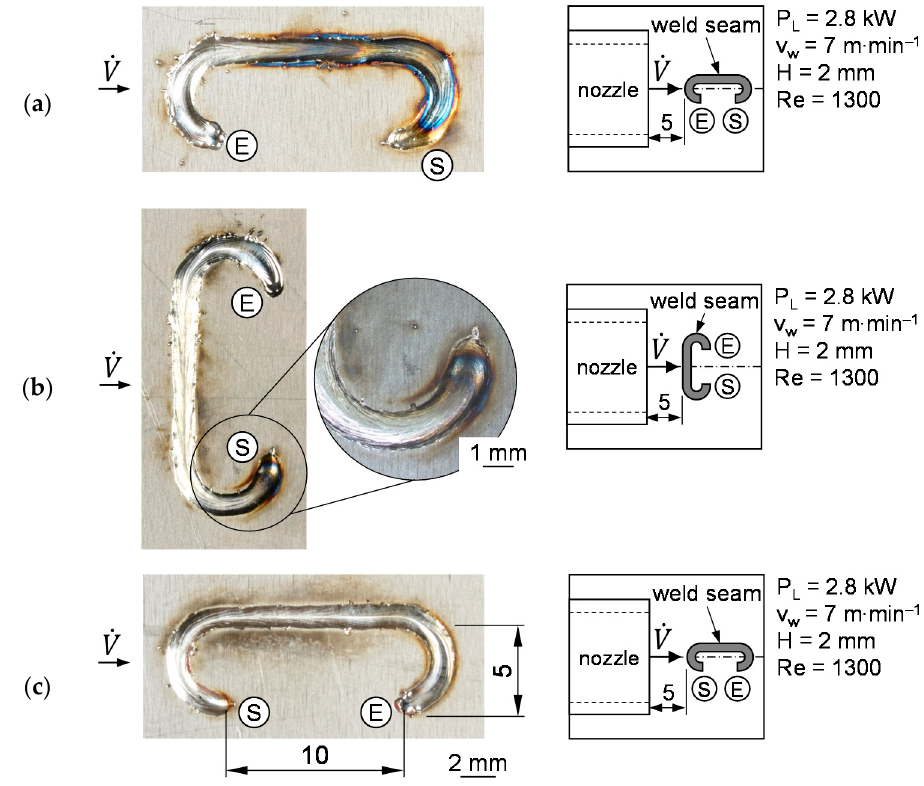
Figure 14. Tarnishing on C-shaped weld seams depending on welding direction: ( a ) weld direction opposite to flow direction; ( b ) weld direction perpendicular to flow direction; ( c ) weld direction equal to flow direction.